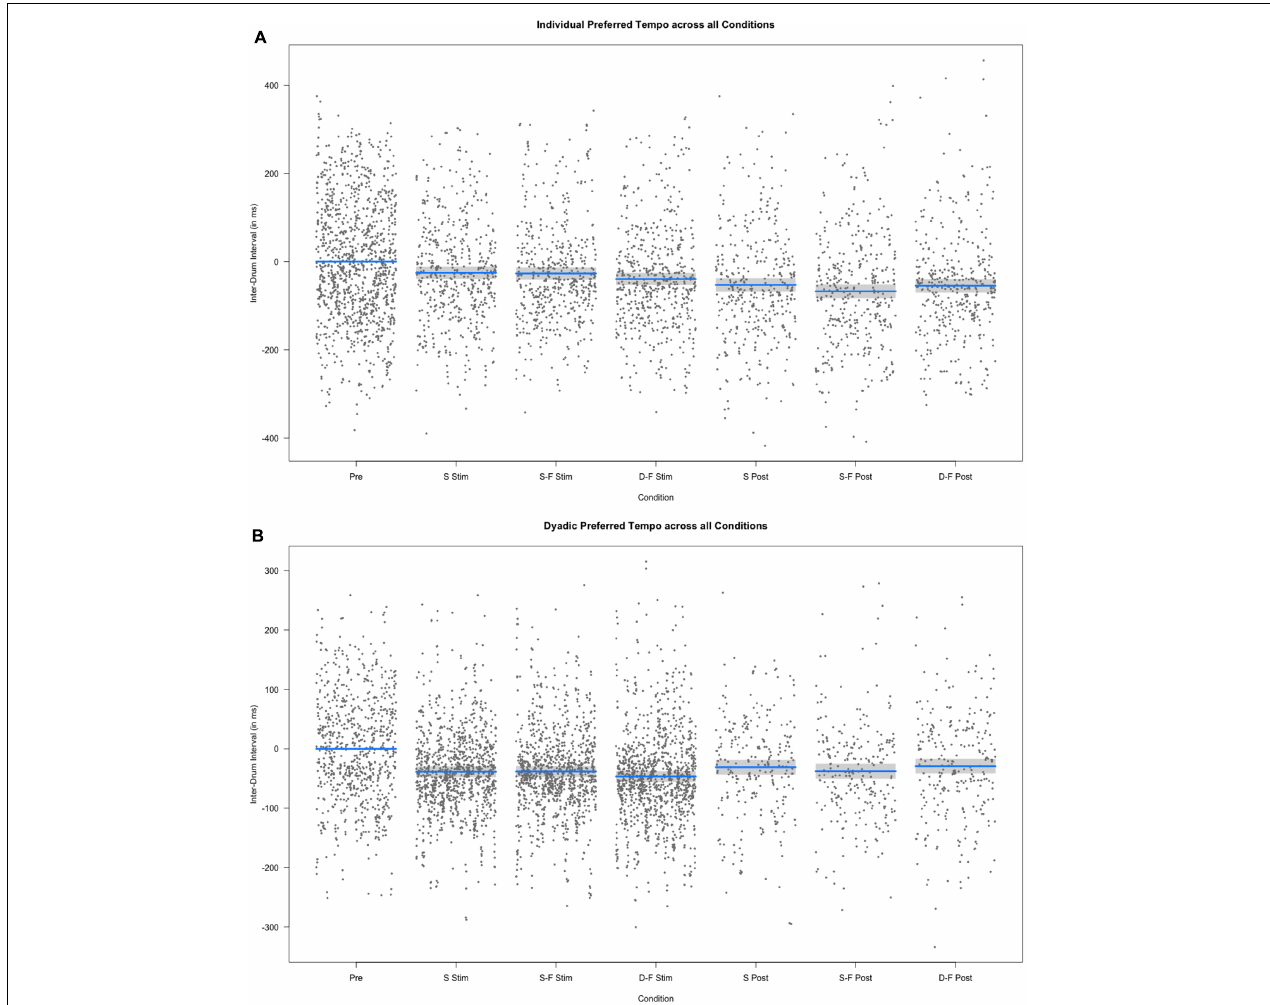
FIGURE 6 | Results of the fixed effect of the linear mixed model analysis for the effect of condition on individual and dyadic preferred drumming tempo. (A) Partial residuals as estimated by the mixed model for individual preferred drumming tempo. (B) Partial residuals as estimated by the mixed model for dyadic preferred drumming tempo. Stimulation conditions: Pre, pre; S Stim, sham stimulation; S-F Stim, same-phase-same-frequency stimulation; D-F Stim, different-phase-different-frequency stimulation; S Post, sham post; S-F Post, same-phase-same-frequency post; D-F Post, different-phase-different-frequency post. Blue lines indicate model prediction values. 95% confidence intervals are displayed as gray